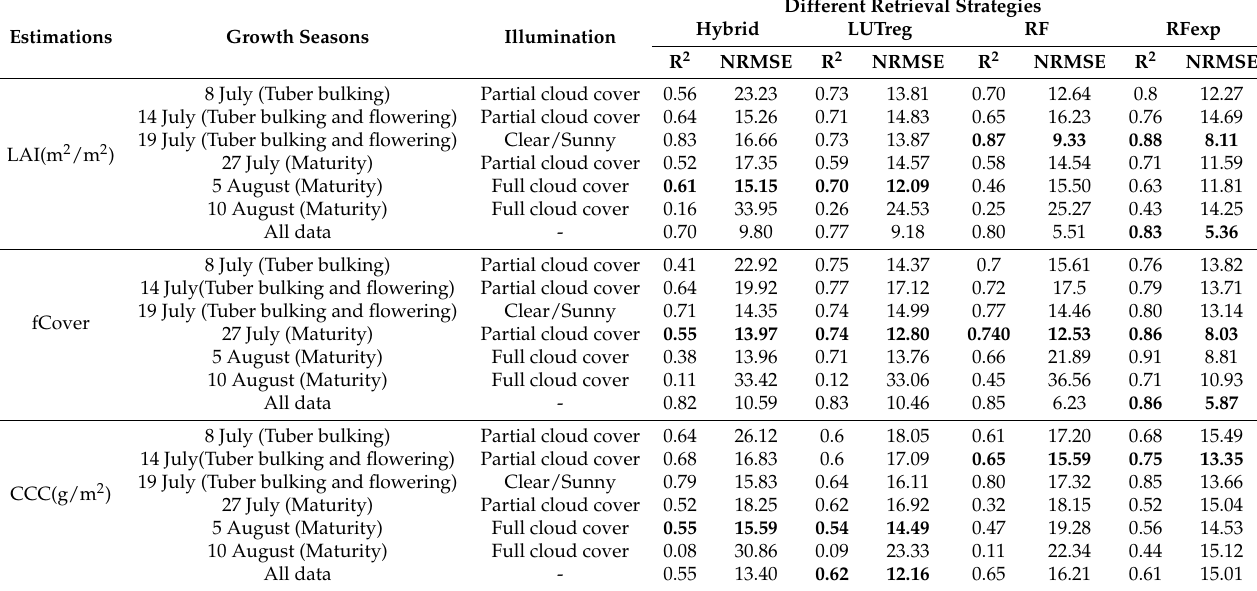
Table 6. The coefficient of determination (R 2 ) and Normalized Root Mean Square Error (NRMSE %) values obtained from different retrieval